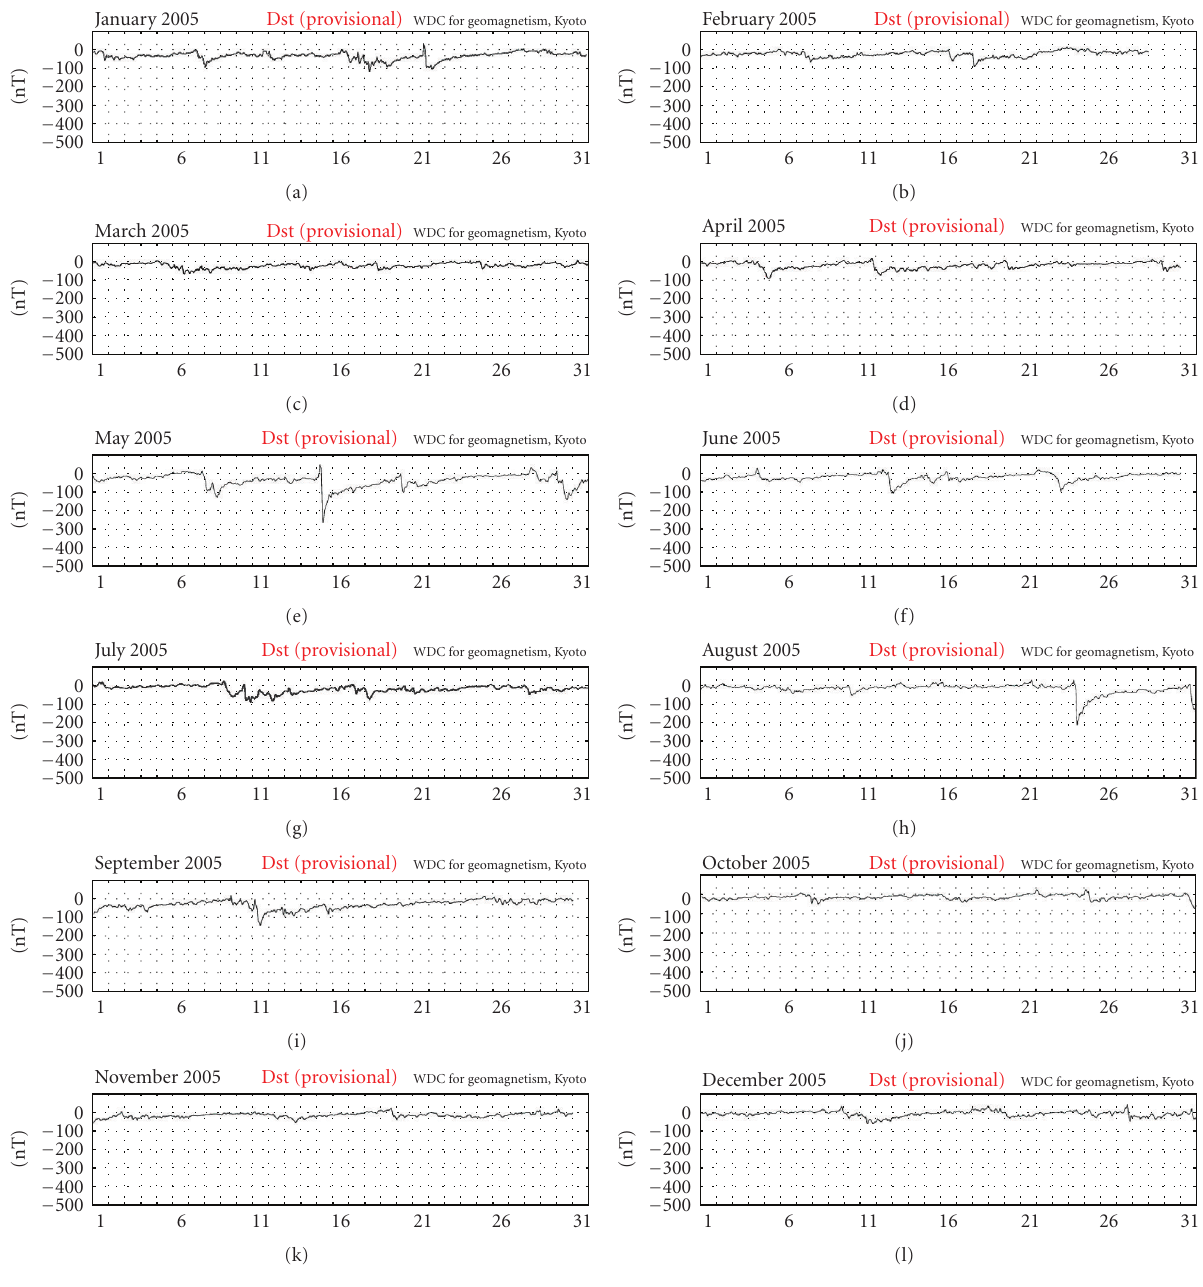
Figure 10: This figure denotes the Dst indices for year 2005 in